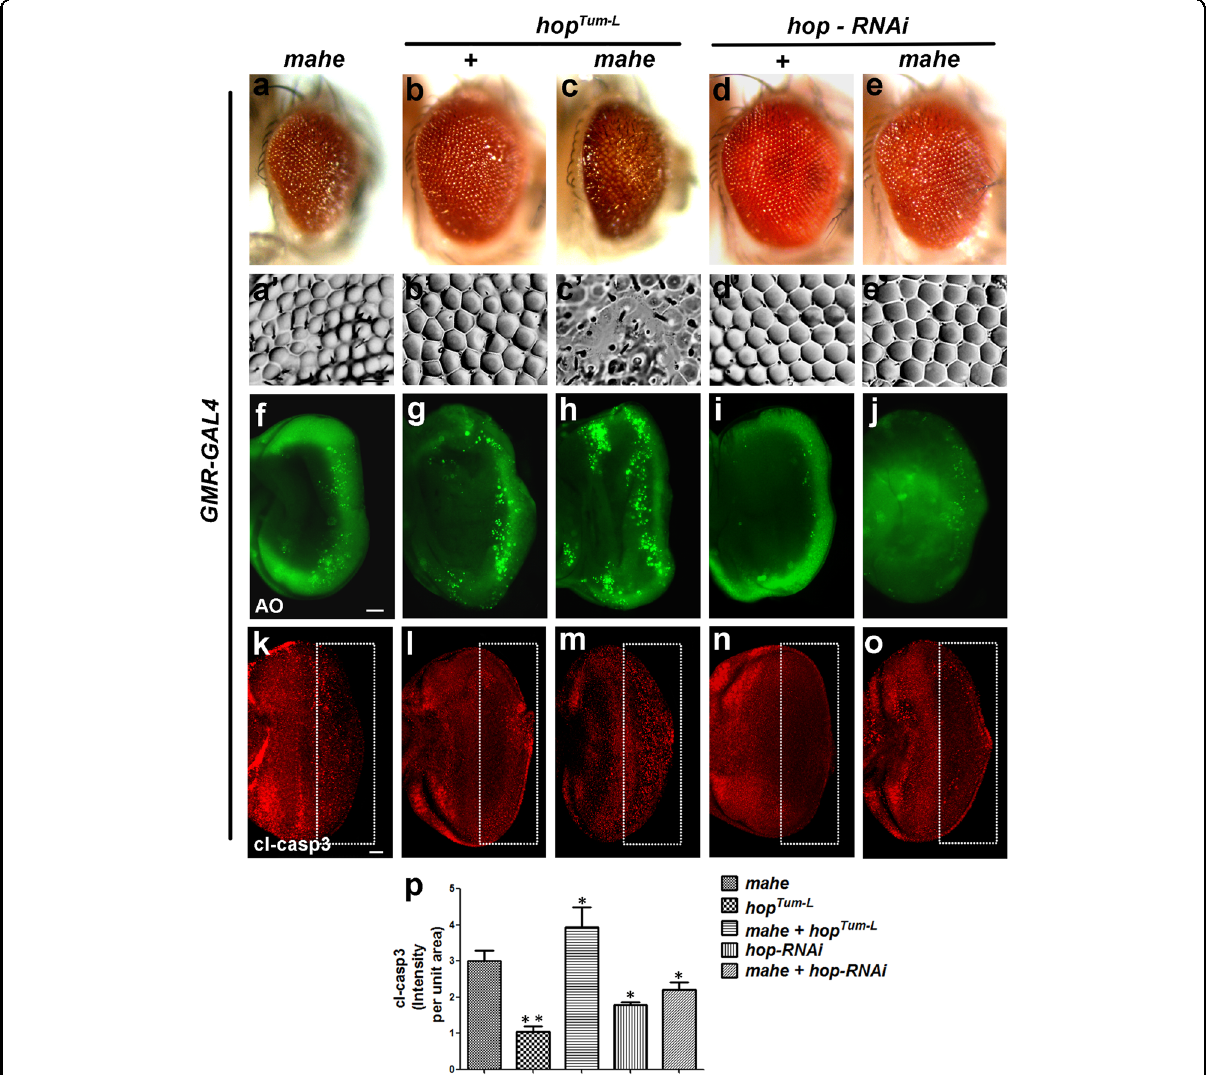
Fig. 5 hopscotch enhances mahe induced cell death. ( a – e ) Images of Drosophila adult eye. a ′ – e ′ Adult eye imprints. a , c , e GMR-GAL4 was used to drive UAS-mahe or ( b , c ) UAS-hop (Tum-l) ( d , e ) UAS-hop-RNAi . a , a ′ Ectopic mahe expression promotes eye roughening. b , b ′ Overexpression of constitutive active form of hop results in slight ommatidial disorganization. c , c ′ Coexpression of hop and mahe enhanced the rough eye phenotype compared to mahe alone. d , d ′ Reduction of hop levels by RNAi mediated knockdown leads to no observable change in eye roughening phenotype. e , e ′ RNAi mediated depletion of hop rescued the mahe induced eye roughness. f – j , k – o Acridine orange and caspase staining in eye antennal disc. f , k Acridine and caspase positive cells show cell death induced by mahe . g , l hop Tum-l overexpression showed few dying cells. h , m Coexpession of hop Tum-l and mahe enhanced cell death in comparison to mahe alone. i , n No dying cells were observed on downregulating the level of hop. j , o Downregulation of hop rescued the mahe induced cell death as depicted by acridine orange and cl-caspase staining. p Graph represents cl- caspase intensity per unit area which shows activated hop Tum-l promotes mahe induced cell death, which was signi fi cantly reduced in combination with hop-RNAi . One-way ANOVA. Scale bar in 50 µm ( f – j , k – o) . Genotypes ( a ) w; + ; GMR-GAL4,UAS-HA-mahe/ + ( b ) w; UAS-hop Tum-l / + ;GMR-GAL4/ + ( c ) w; UAS-hop Tum-l / + ;GMR-GAL4,UAS-HA-mahe/ + ( d ) w; UAS-hop-RNAi/ + ;GMR-GAL4/ + ( e ) w; UAS-hop - RNAi/ + ; GMR-GAL4,UAS-HA-mahe/ + . One-way ANOVA * P < 0.05, ** P < 0.01, *** P <